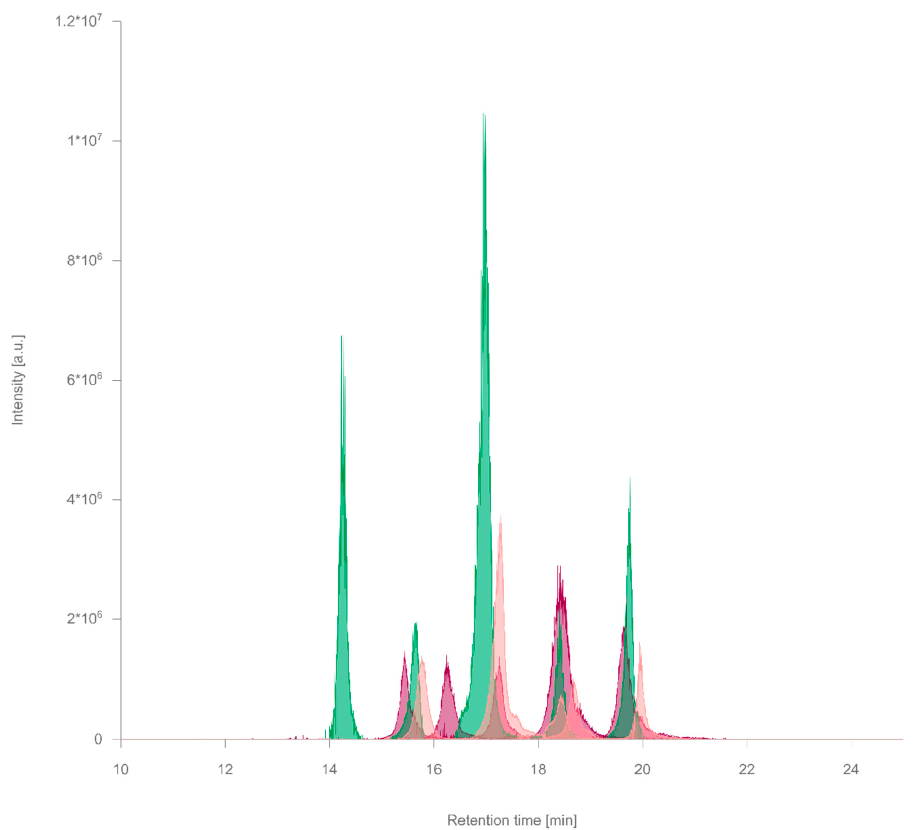
Figure A2. Comparison of the RP-HRMS/MS GIPC profiles in spinach (green), strawberry (rose) and raspberry (dark-red), showing the five most abundant GIPCs found in each plant sample measured in positive ion mode (detailed information can be found in Table A1).